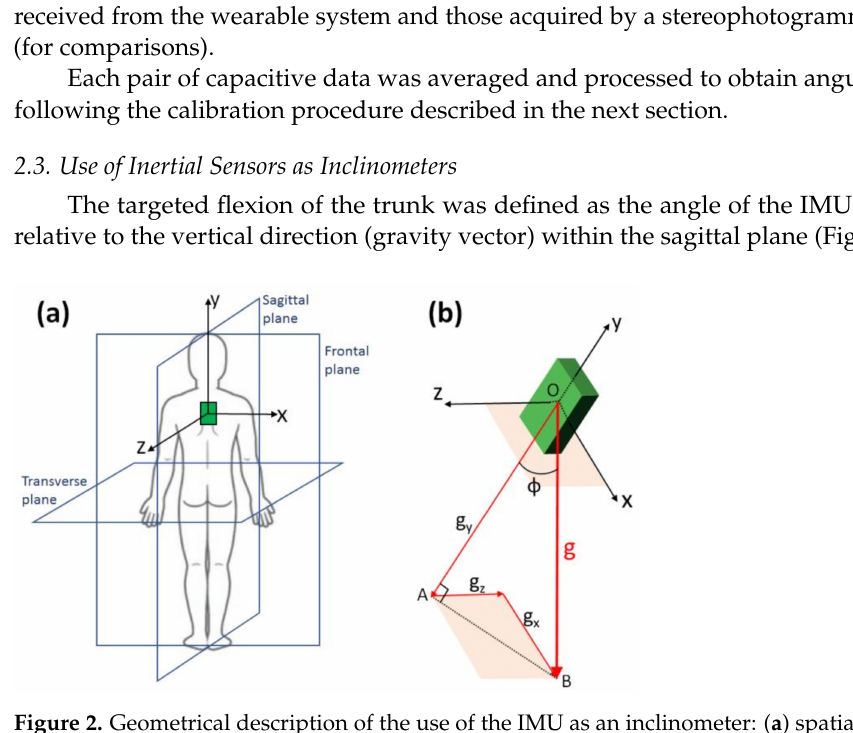
Figure 2. Geometrical description of the use of the IMU as an inclinometer: ( a ) spatial arrangement of the IMU axes; ( b ) definition of a generic inclination of the IMU relative to